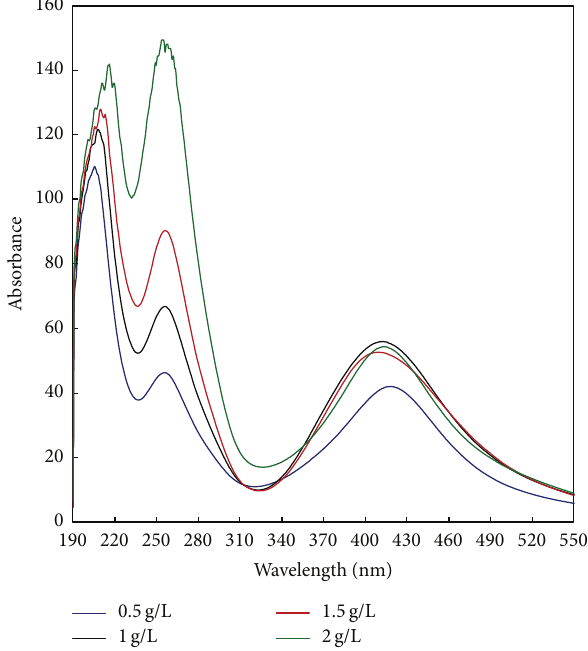
Figure 2: Effect of silver nitrate concentration on the synthesis of silver nanoparticles [CMS], 50 g/L; [PI], 1g/L; [AgNO 3 ], 0.5–2 g/L; temp., 30 ∘ C; time, 60 min.; M: L ratio, 1: 20; pH,